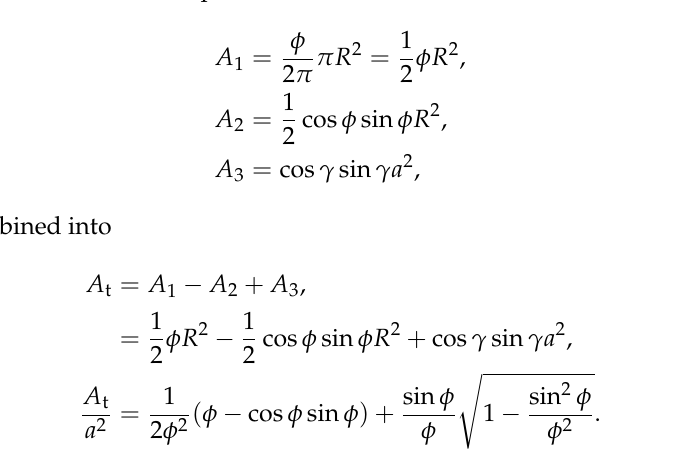
Figure 7. Partial cross-sectional areas A 1 , A 2 , and A 3 . These partial areas are computed as